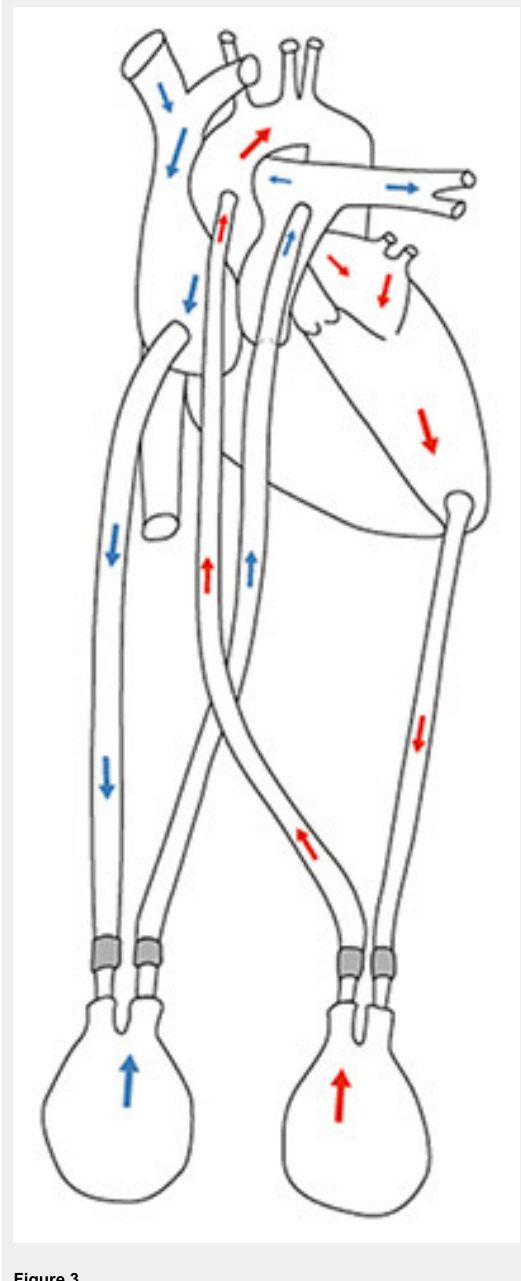
Schema of the BVAD Berlin Heart (blue arrows = venous blood flow, red arrows = arterial blood flow). (Property of Julia Schrempf, Graz,